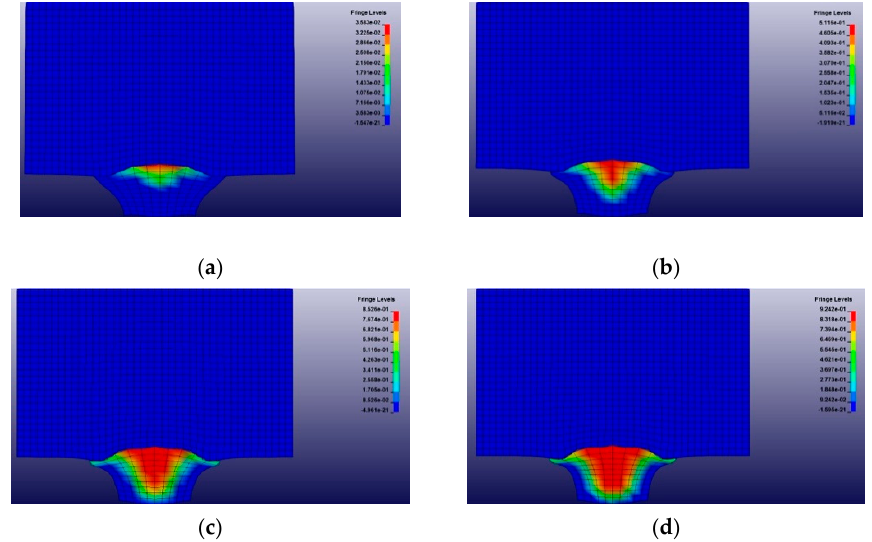
Figure 14. Extent of the chemical reaction y nephogram at different impact velocities under maximum